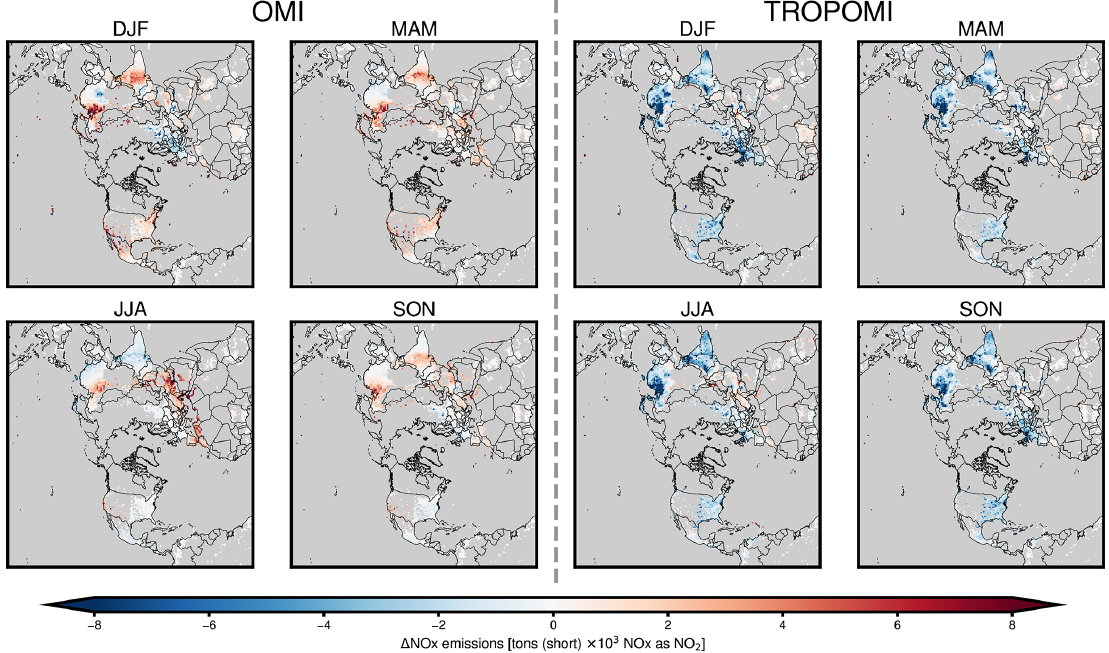
Figure 6. Season-average NO x emissions changes from inverse modeling updates based on OMI and TROPOMI observations. Emissions changes are shown for winter (DJF), spring (MAM), summer (JJA), and fall (SON).